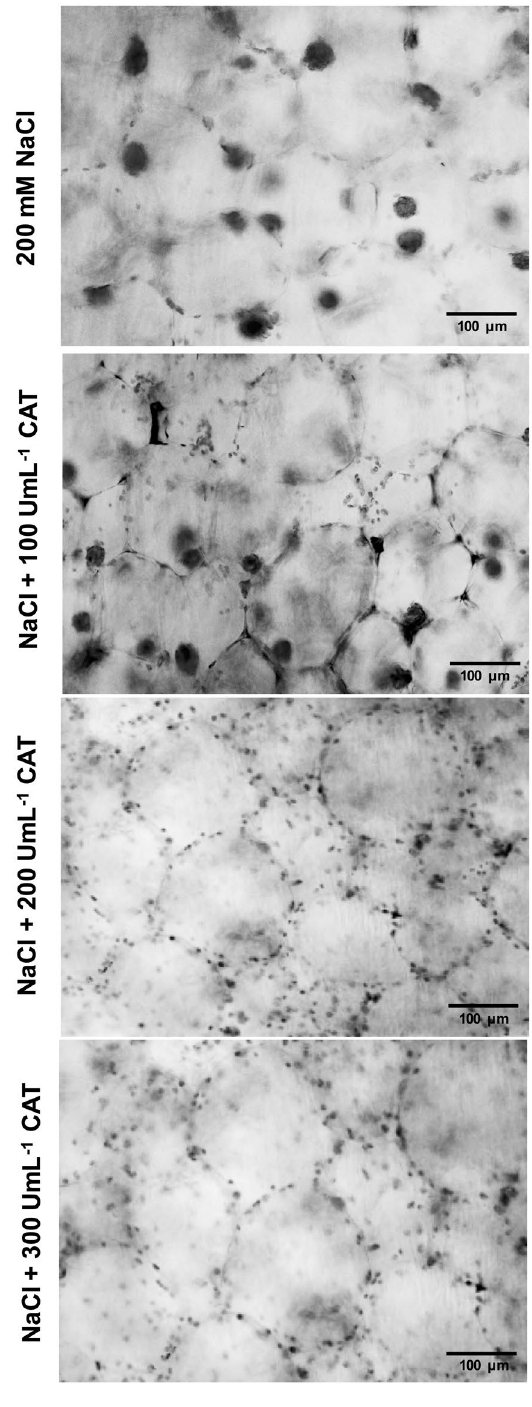
Figure 5. Chloroplast arrangement in chlorenchyma cells from Opuntia streptacantha under NaCl treatment supplemented with CAT. Representative images of O . streptacantha cells and their chloroplasts are shown in each panel. The cladode segments from O . streptacantha were incubated in 200 mM NaCl, 200 mM NaCl + 100 UmL − 1 CAT, 200 mM NaCl + 200 UmL − 1 CAT, and 200 mM NaCl + 300 UmL − 1 CAT under white light conditions (300 µ mol m − 2 s − 1 ) for 8 h. Transverse sections from cladode were observed with a light microscope. Scale bar corresponds to 100 μ